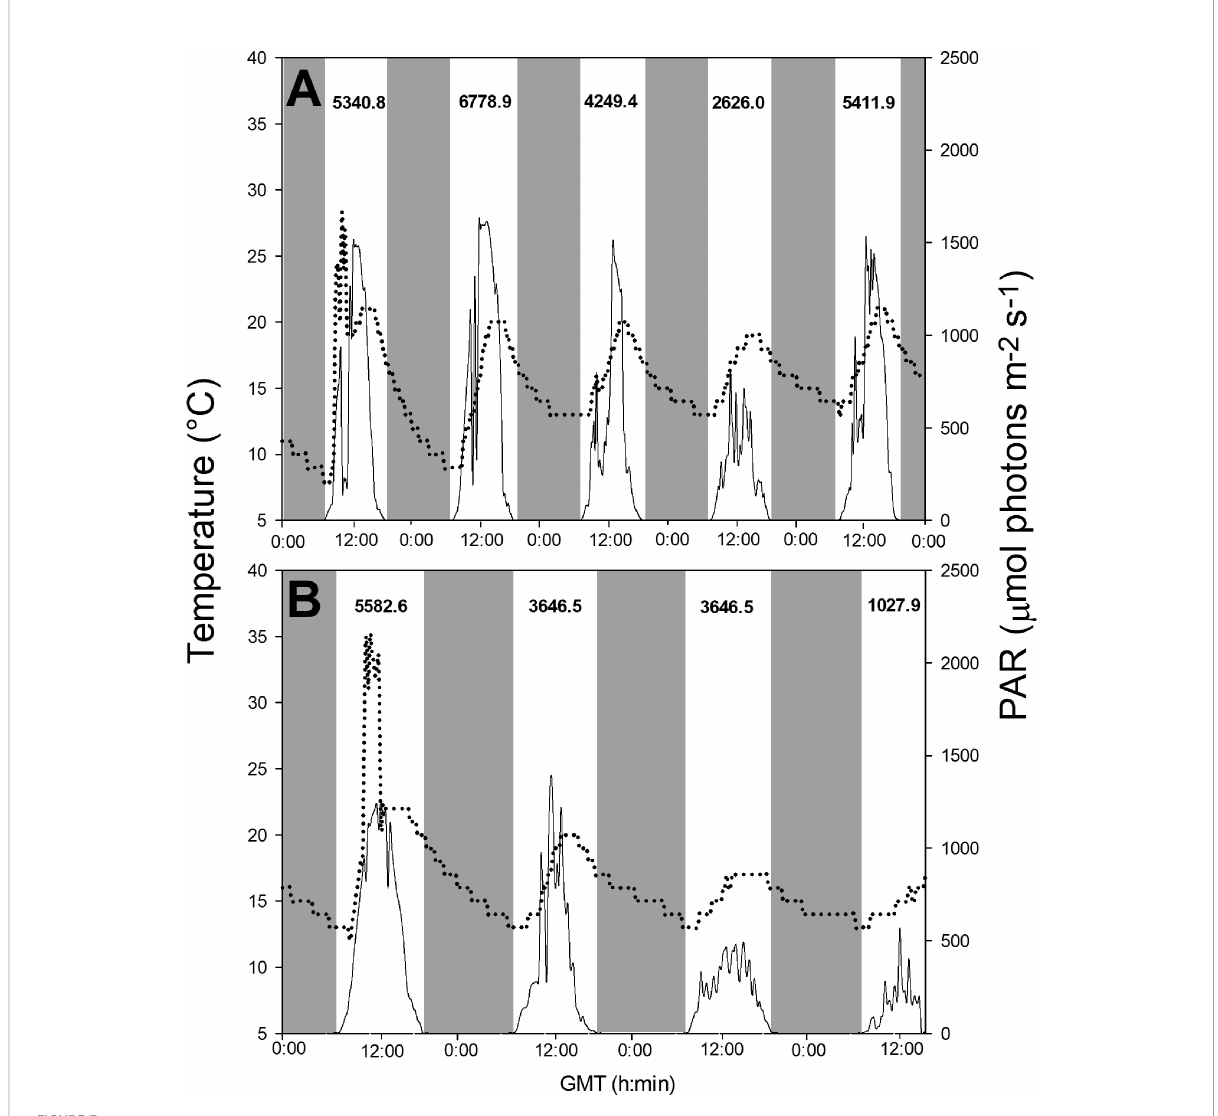
FIGURE 3 Variation in temperature (°C, dotted line) and photosynthetically active radiation (PAR, µmol photons m -2 s -1 , solid line) data during the experimental cultivation period of U. pseudorotundata and U. rigida in fi sh ef fl uents. (A) daily temperature and daily solar irradiance